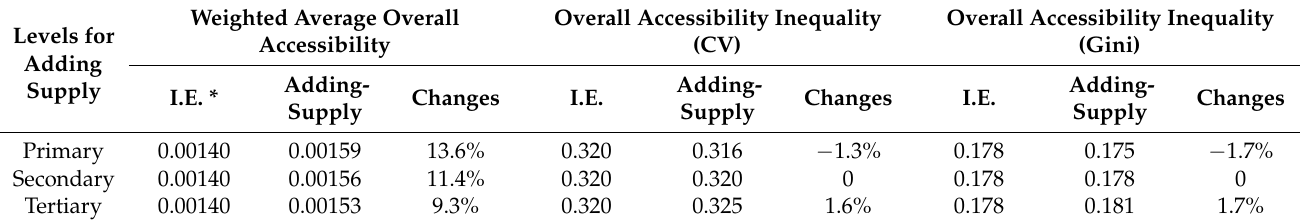
Table 3. Adding-supply accessibility impacts of hierarchical healthcare system in Shenzhen.